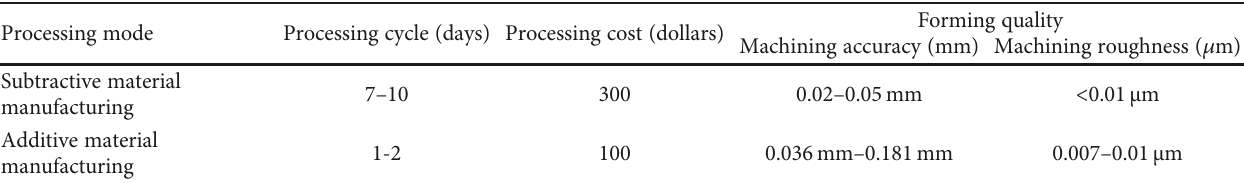
Table 8: Comparison of two processing methods for manufacturing spur face gear master mould. Processing